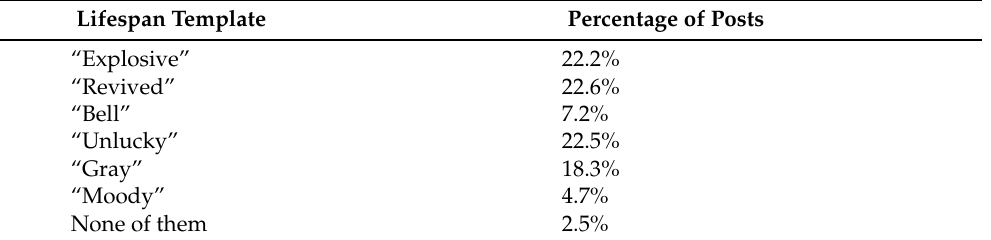
Table 9. Distribution of the posts of our dataset against lifespan